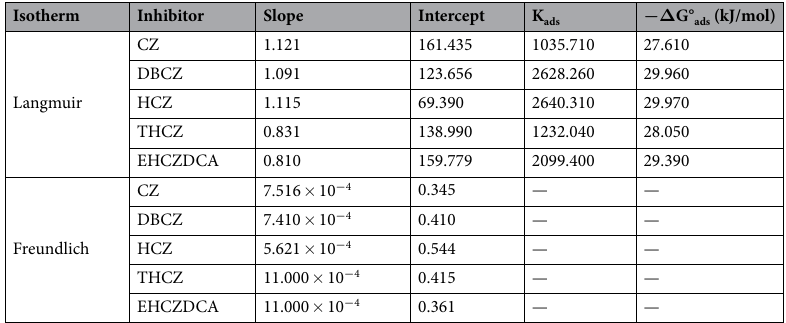
Table 5. Langmuir and Freundlich parameters for the adsorption of CZs on mild steel surface obtained from Tafel parameters at 303